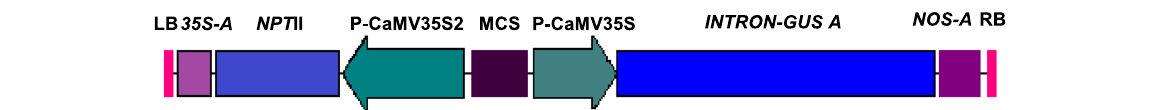
Fig. 1 T-DNA regions of binary vector pCAMBIA2301 used for the in planta transformation have the NPT II gene as plant selectable marker in the left border (LB) driven by CaMV35S2 promoter and CaMV35S terminator and Intron – GUS A as a reporter gene in the right border (RB) driven by CaMV35S promoter and NOS-terminator